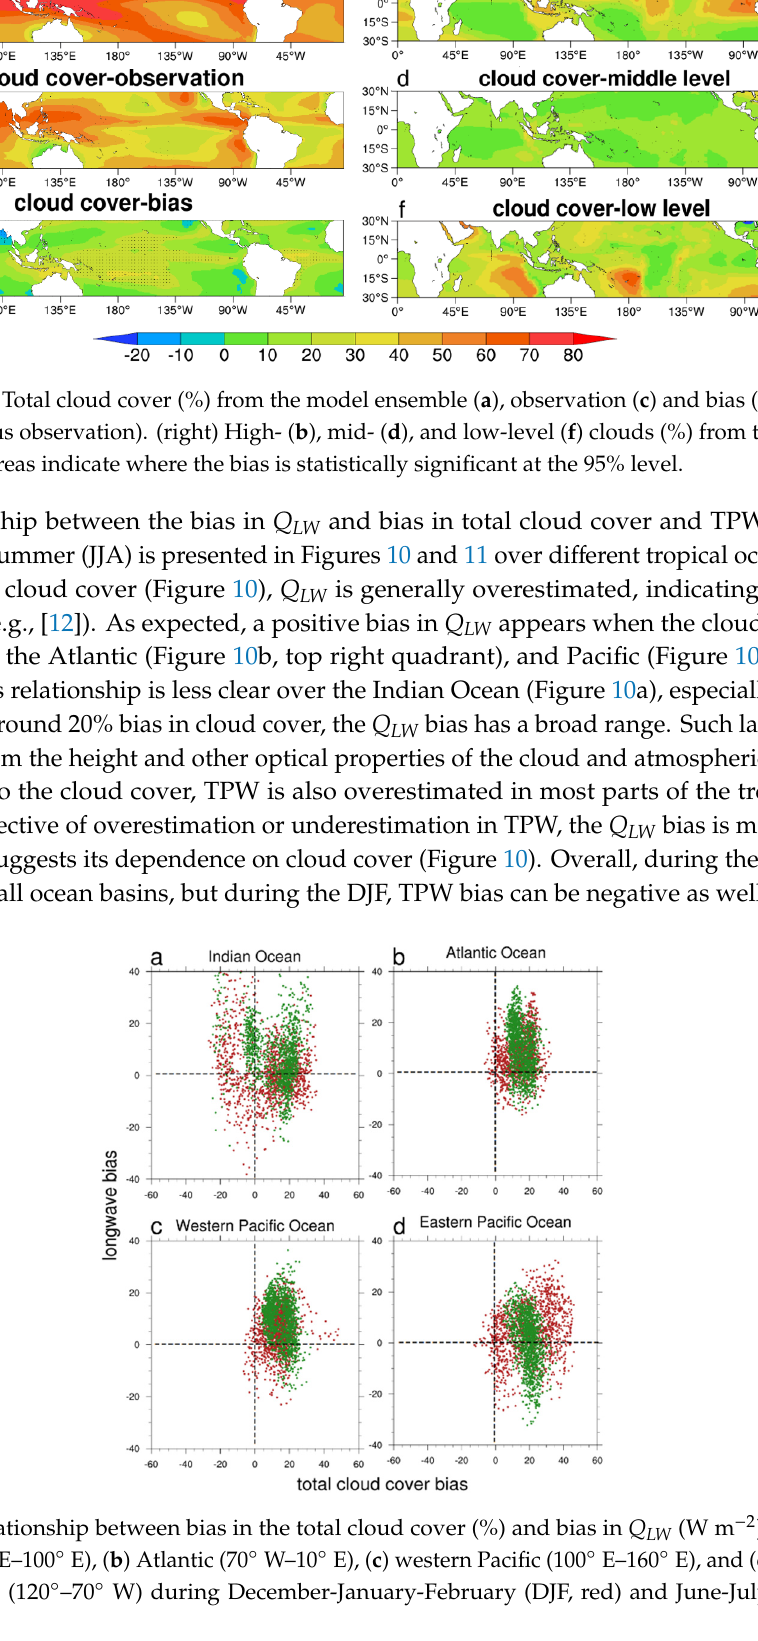
Figure 11. Relationship between bias in the total precipitable water TPW (Kg m − 2 ) and bias in Q LW (W m − 2 ) over the ( a ) Indian (40 ° E–100 ° E), ( b ) Atlantic (70 ° W–10 ° E), ( c ) western Pacific (100 ° E–160 ° E ), and ( d ) eastern Pacific Oceans (120 ° –70 ° W) during DJF (red) and JJA (green). 5. Dependence on Model Resolutions The horizontal resolution of the model has been found to be an important factor in correctly simulating surface radiation (e.g., [10,12,15,52]). Therefore, we examine to what extent the spatio-temporal bias of surface radiative fluxes in the models is related to the horizontal resolutions of the models. This analysis is useful because it provides guidance when choosing a suitable resolution for a model,